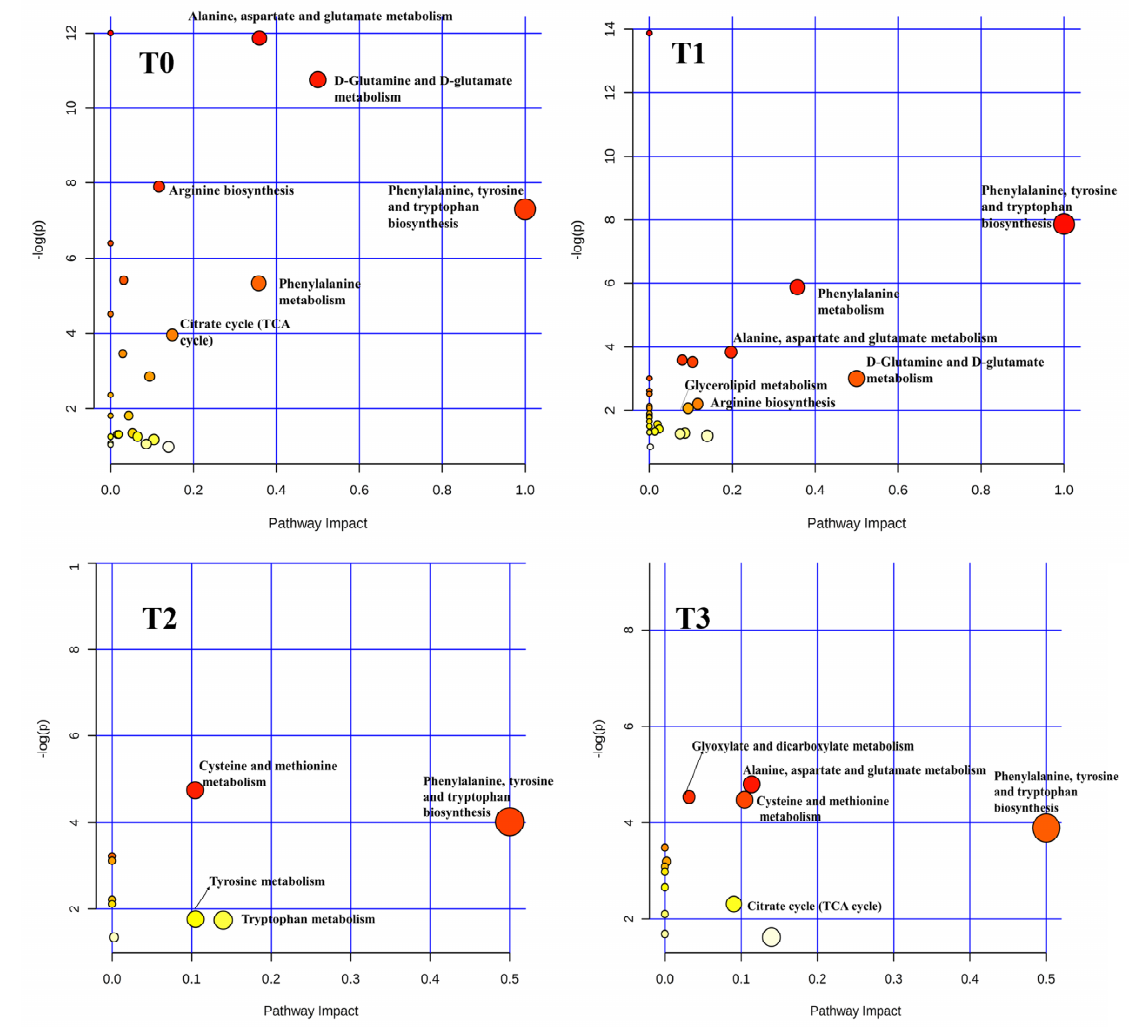
Figure 5. Significantly changed pathways of pigs in the sodium butyrate (SB) group compared with the control (Con) group at T0 (0 min, n = 7), T1 (30 min, n = 7), T2 (60 min, n = 7), and T3 (120 min, n = 6) after intravenous infusion. Here, the x -axis marks the pathway impact and the y -axis represents the pathway enrichment. Each node marks a pathway, with larger sizes and darker colors representing higher pathway enrichment and higher pathway impact